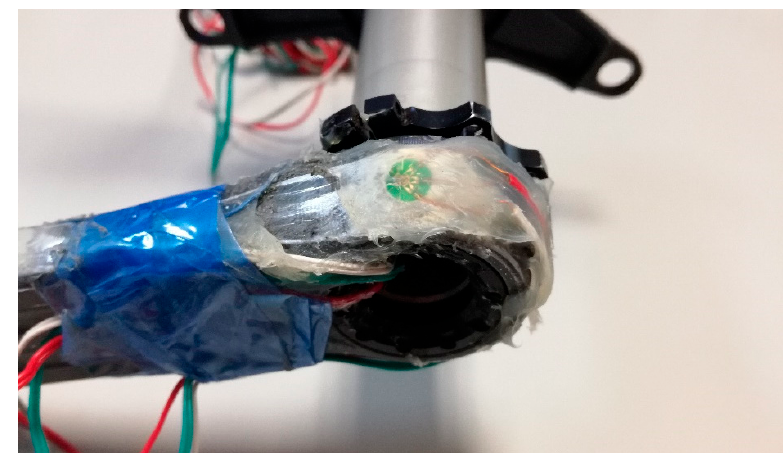
Figure 3. Position of the strain gauge rosette #3.